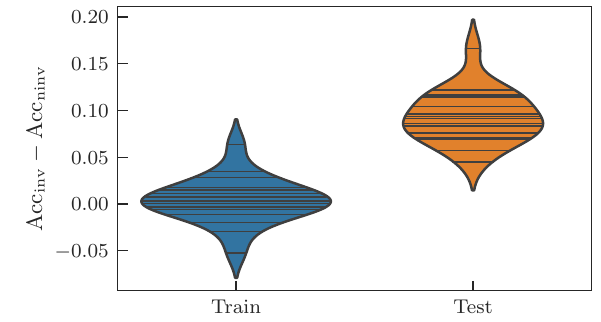
FIG. 5. Violin plot of the difference in achieved accuracies between the invariant and noninvariant models for 20 random parametrizations of the trainable blocks as detailed in the text. Positive values correspond to invariant models outperforming noninvariant ones. The values for every parametrization are aver- aged over ten repetitions with random parameter